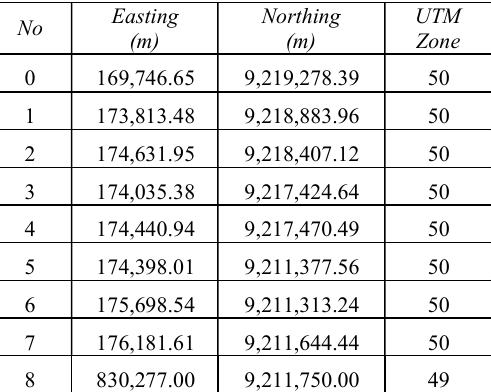
Figure 6. 1 st Matrix Waveheight Distribution